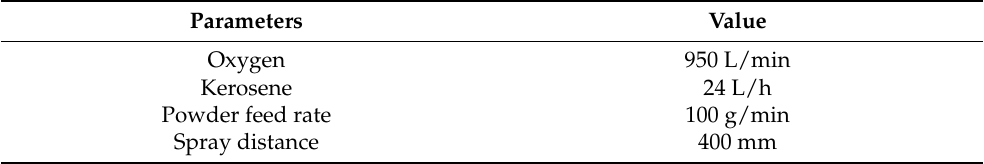
Table 2. HVOF parameters for spraying coatings.